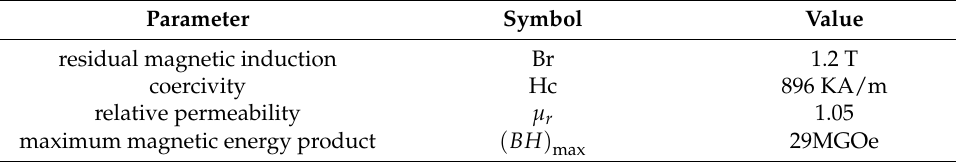
Table 2. Detailed parameters of permanent magnet.